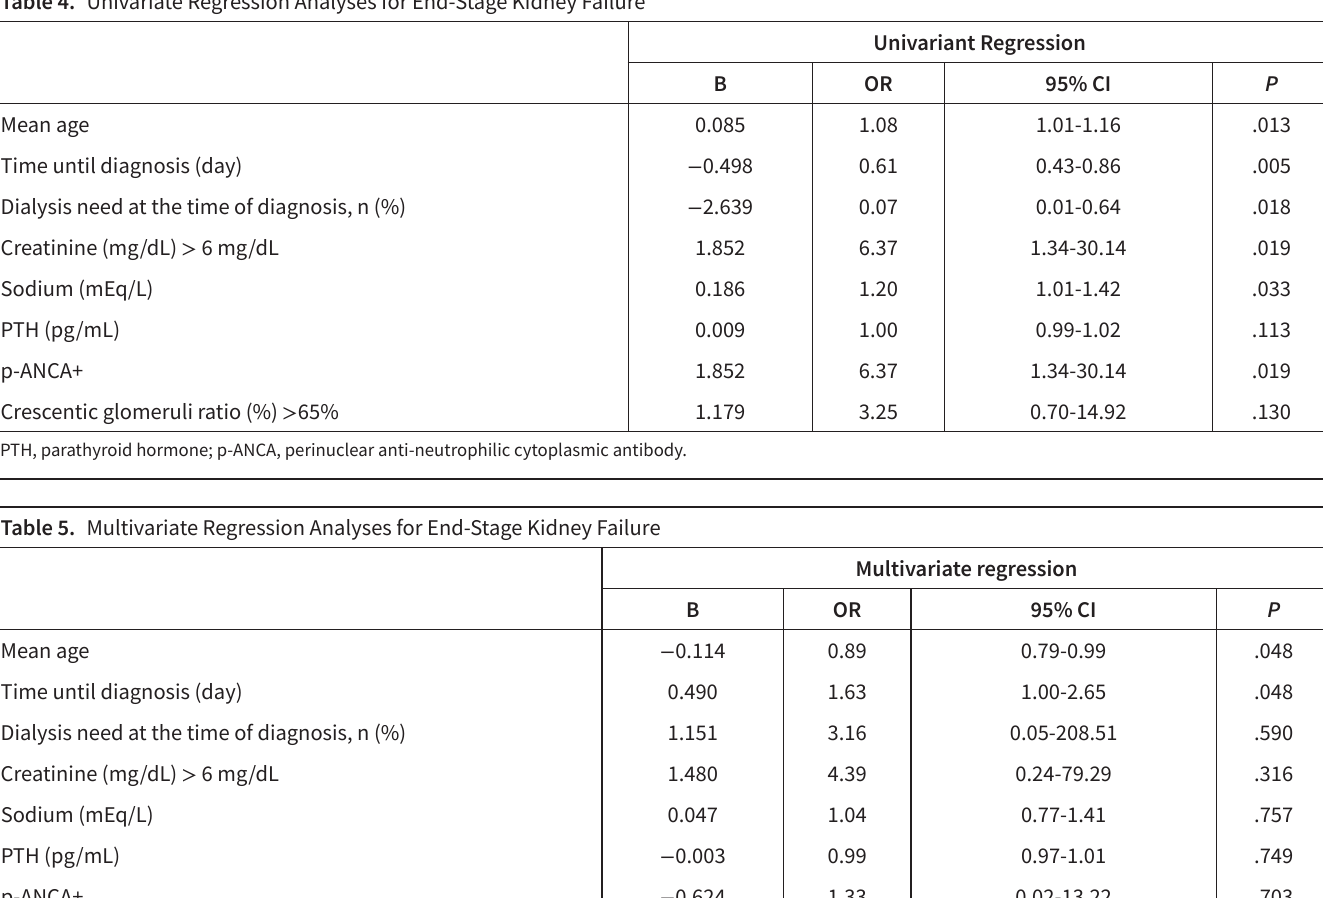
Table 4. Univariate Regression Analyses for End-Stage Kidney Failure